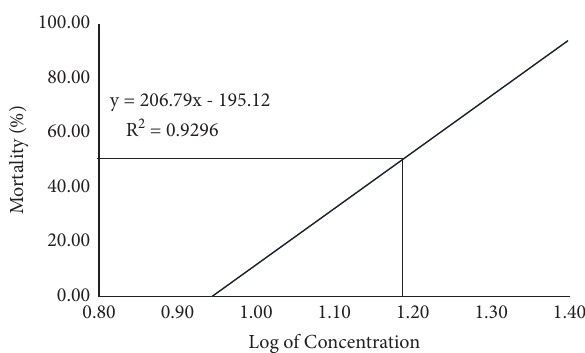
Figure 1: Graph showing linear transformation and the rela- tionship of a probit of log concentration of profenofos used to determine LC 50 .